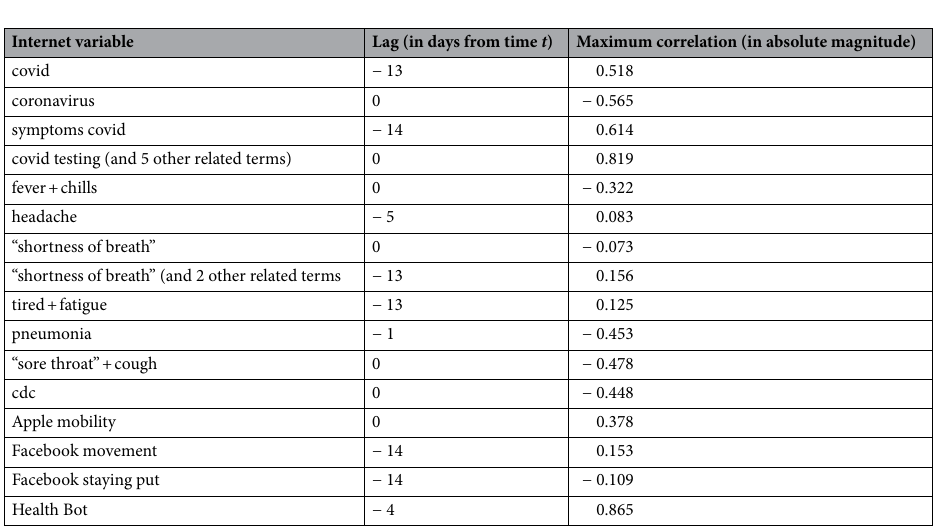
Table 2. Internet variables and maximum absolute correlation with census in previous 14